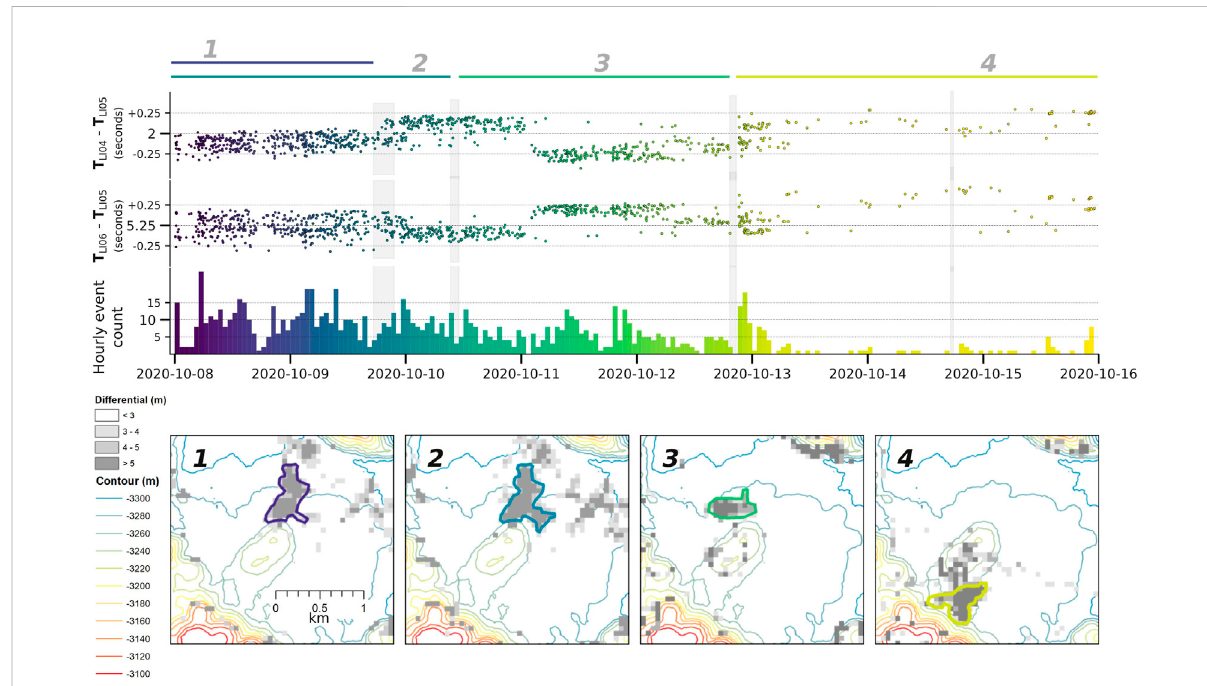
barsindicatetheoccurrenceofeachMBESsurveyusedtoproduceelevationdifferencemaps.Bottompanel:mapsoftheTikTakareashowingdepth differences greater than 3 m (gray scale) between MBES surveys (1: October 6 – 9; 2: October 6 – 10; 3: October 10 – 12; 4: October 12 – 17). The same color is used on the maps to outline the reliable depth differences interpreted as new volcanic